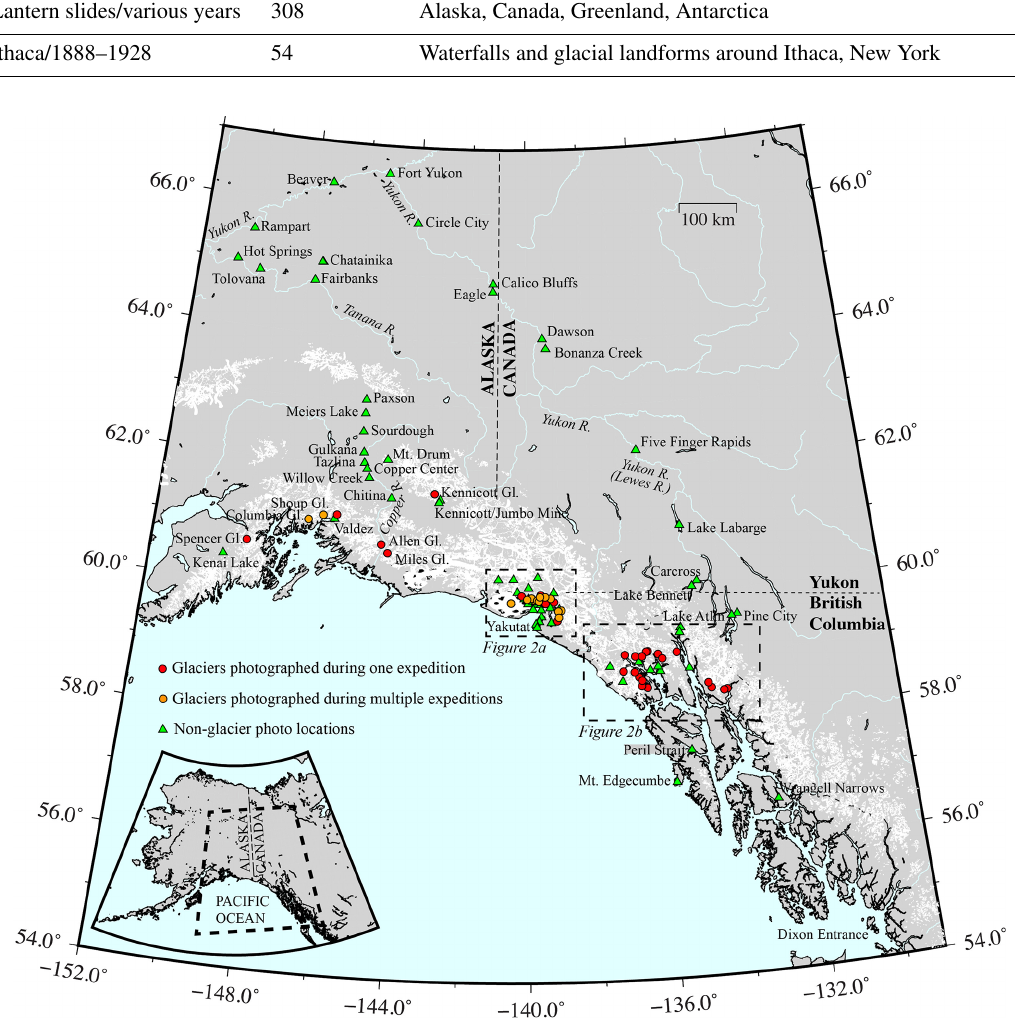
Figure 1. Locations visited during expeditions to Alaska between 1905 and